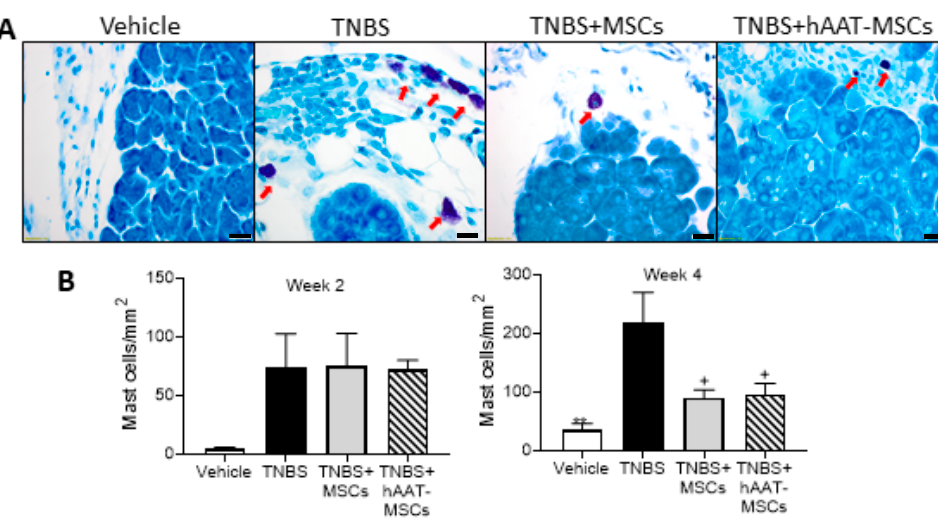
Figure 5. Pancreatic mast cell density is reduced in both groups of human alpha-1 antitrypsin-overexpressed mesenchymal stromal cells (hAAT-MSC) and MSC-treated mice compared to trinitrobenzene sulfonic acid (TNBS) mice. ( A ) Pancreatic sections were stained for mast cells using May-Grünwald–Giemsa stain (Vehicle = 3, TNBS = 3, TNBS + MSCs = 3 for week 4 and 4 for week 2, TNBS + hAAT-MSCs = 3 mice per group). Arrows indicated mast cells. Scale bars represent 20 µm. ( B ) Both groups of MSC mice had reduced mast cell density. Data are showed as mean ± SEM. One-way ANOVA and Tukey’s test were used. ** p < 0.01 vs. Vehicle, + p < 0.05 vs. TNBS.